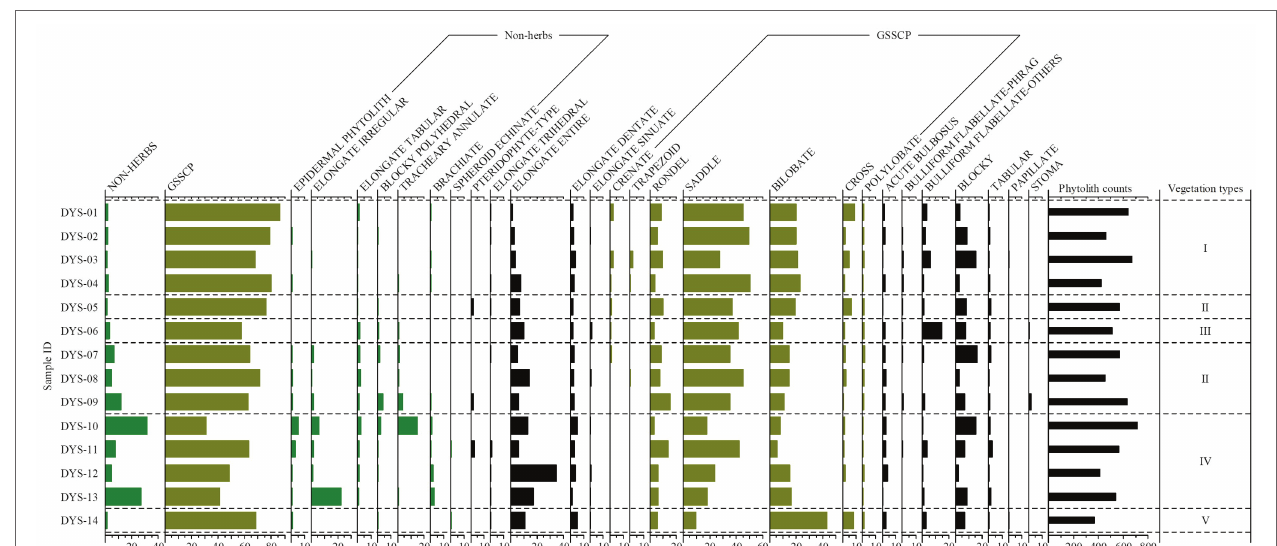
FIGURE 2 | Frequency diagram of phytolith morphotypes observed in topsoil from elevation quadrats in the Daiyun Mountains, China. See Supplementary Table S1 for the full list of phytolith types counted and raw counts per sample. Group I represents evergreen shrub-meadow plots, Group II represents coniferous broadleaf mixed forest plots, Group III represents bamboo forest plot, Group IV represents broadleaf forest plots, and Group V represents anthropogenic deforested shrubland plots,